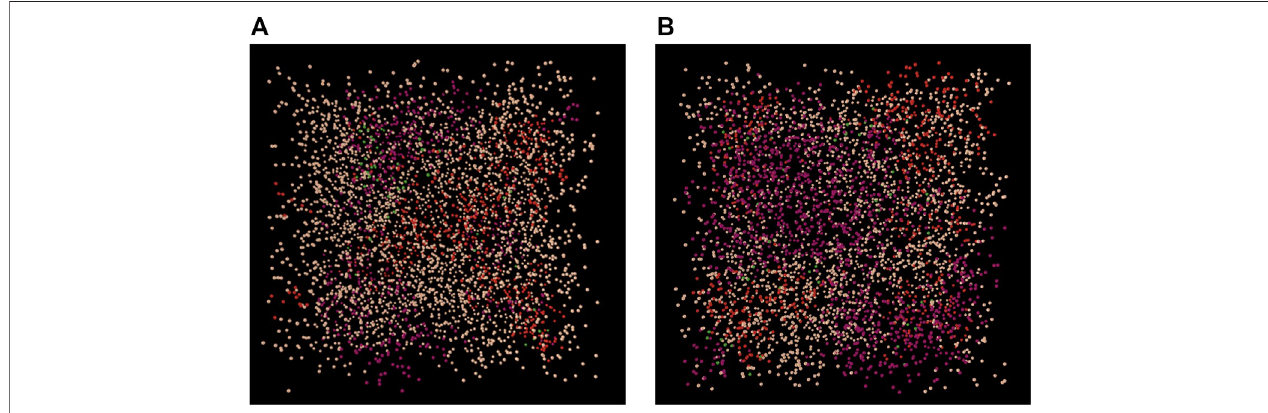
FIGURE 11 | Examples of a in fl ammatory environments within the 3D Agent-based model under optimal (A) and early degenerated (B) nutrition conditions. Cell clusters: red; cells immunopositive for IL1 β , purple; cells immunopositive for TNF- α ; green: cells immunopositive for both, IL1 β &TNF- α .